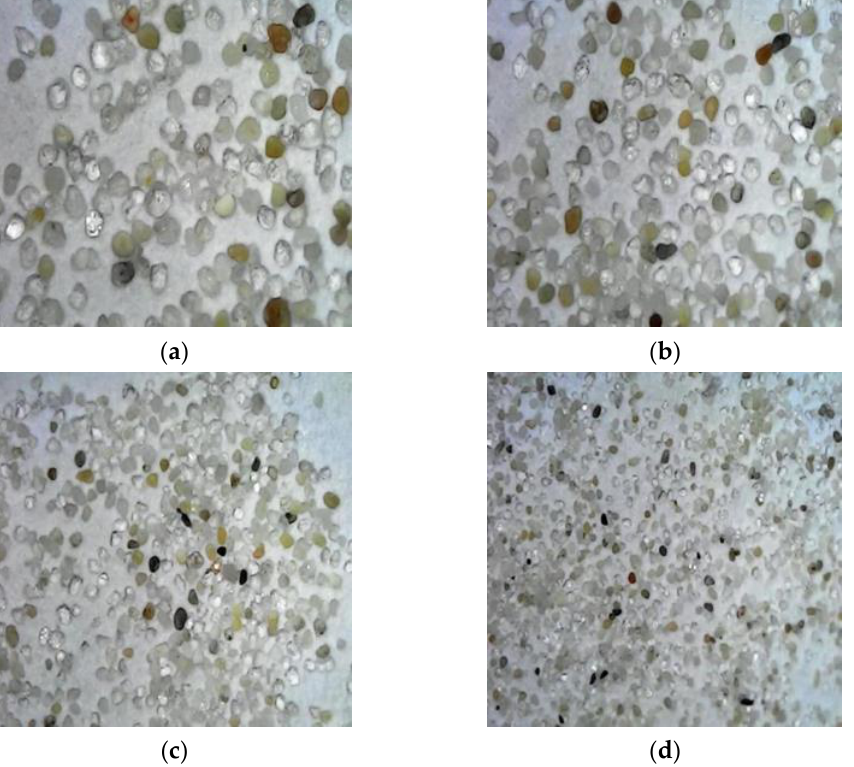
Figure 7. Quartz-sand-sample images of four particle sizes: ( a ) −40 + 70 mesh; ( b ) −70 + 100 mesh ( c ) − 100 + 140 mesh; ( d ) − 140 + 400 mesh.